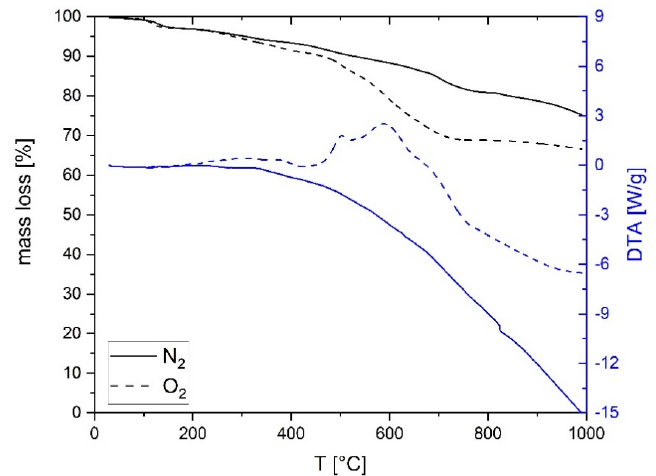
Figure 4. Thermogravimetric (TG) curve (black) and differential thermal analysis (DTA) curve (blue) of black mass heating under O 2 (dashed line) and N 2 (continuous line) atmosphere from 25 to 1000 °C at 10 K/min.